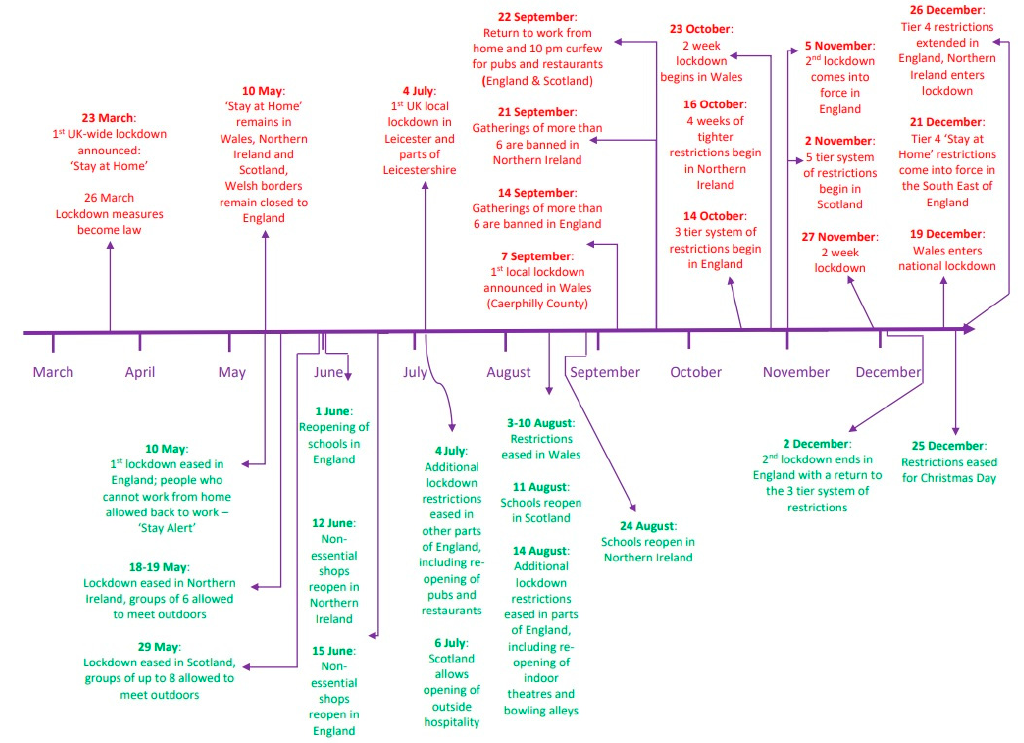
Figure 1. Timeline of the introduction and easing of COVID-19 restrictions in the UK during 2020. The UK entered lockdown on 23 March 2020. Following this the devolved nations (Northern Ireland, Wales and Scotland) followed their own paths in determining restrictions and, in turn, easing restrictions. The events shown here are not exhaustive but serve to demonstrate the main periods of social restrictions upon residents of the UK from 23 March–31 December